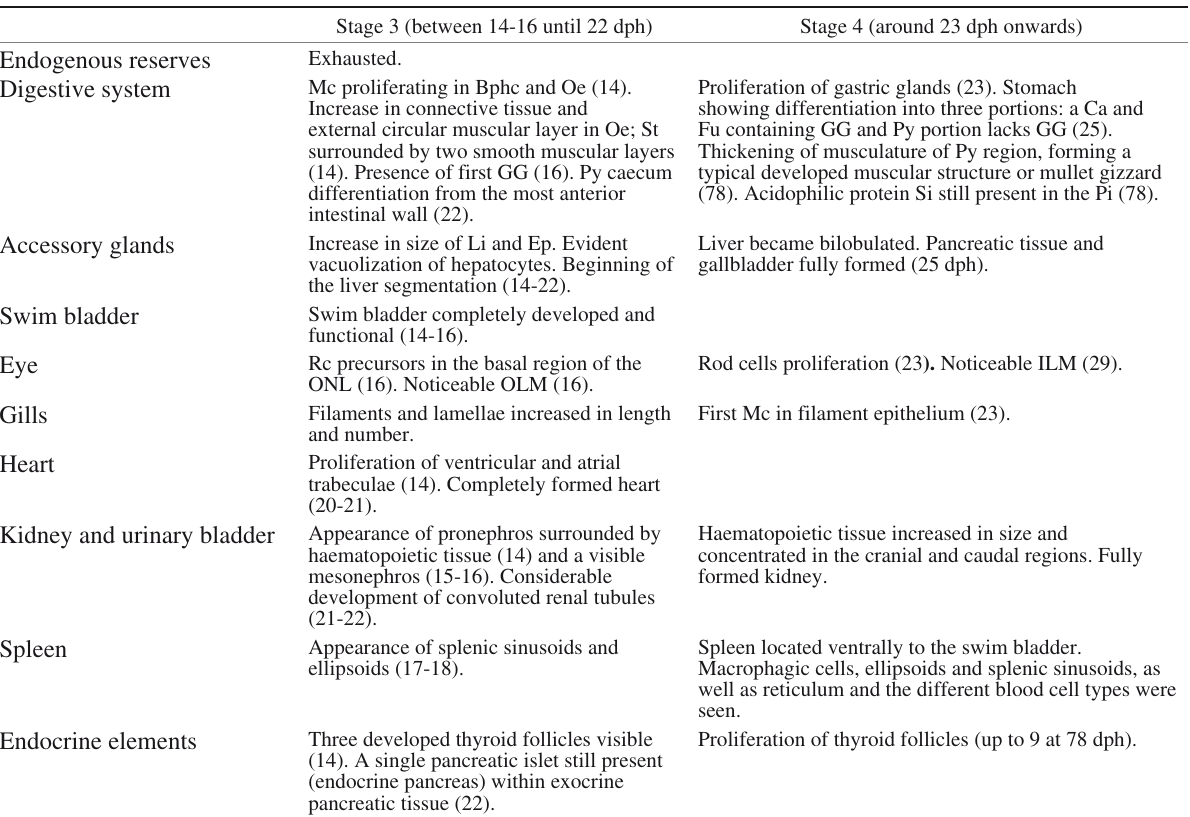
Table 2. – Schematic synthesis of the main ontogenetic events occurring in Chelon labrosus larvae during exogenous (Stage 3) and meta- morphic (Stage 4) phases. Numbers in brackets indicate the age (dph) Bphc, bucopharyngeal cavity; Ca, cardias; Ep, exocrine pancreas; Fu, fundus; GG, gastric glands; ILM, inner limiting membrane; Li, liver; Mc, mucous cells; Oe, oesophagus; OLM, outer limiting membrane; ONL, outer nuclear layer; Pi, posterior intestine; Py, pyloric region; Rc, rod cells; Si, supranuclear inclusions; St, stomach. Stage 3 (between 14-16 until 22 dph) Stage 4 (around 23 dph onwards) Endogenous reserves